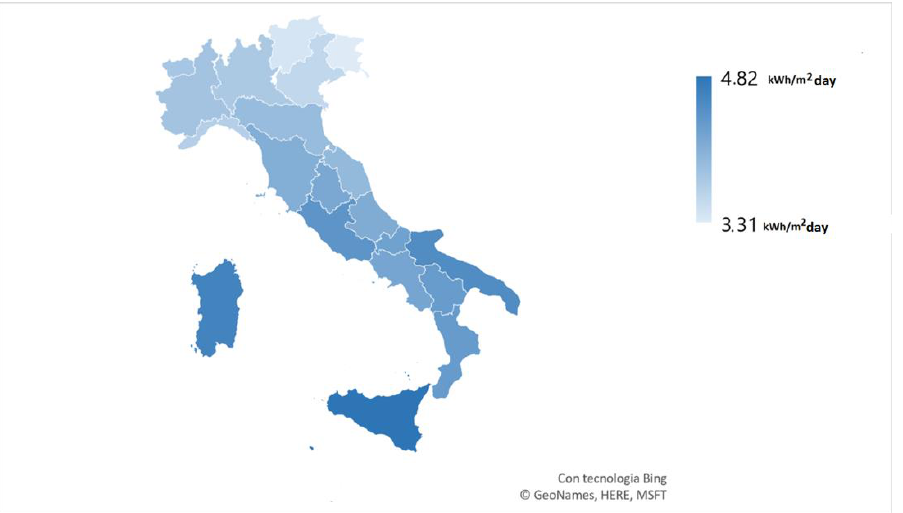
Figure 2. Distribution of yearly averaged DNI in Italy. Adapted from [39].